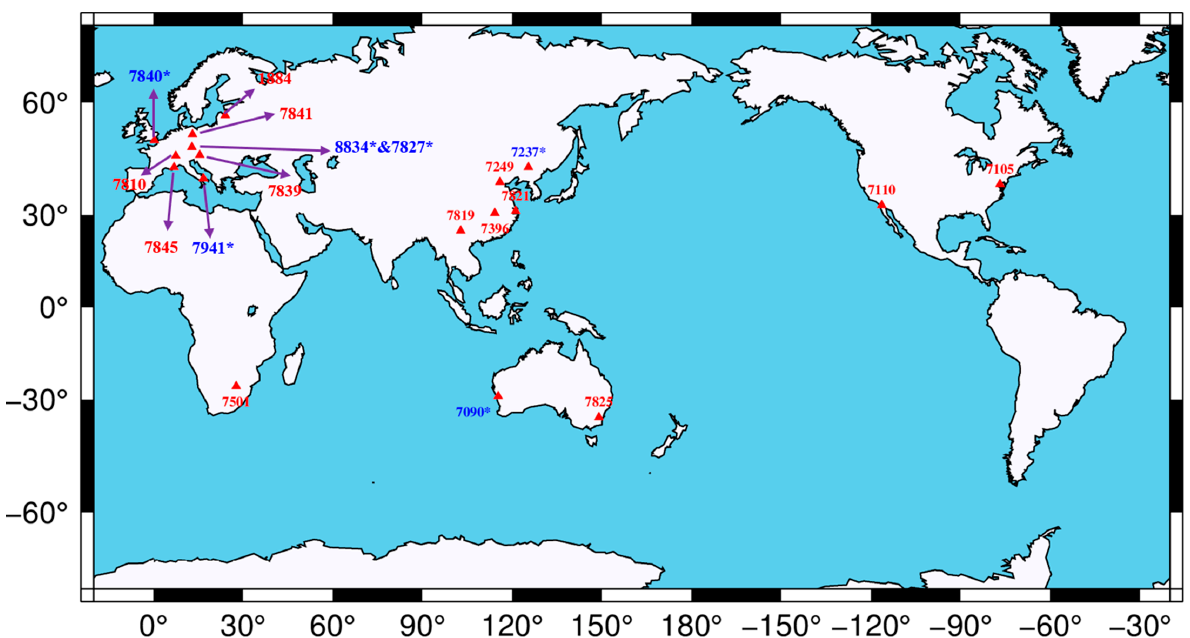
Figure 3. The contribution of each SLR station to the monthly SLR observations of BDS-3 satellites.